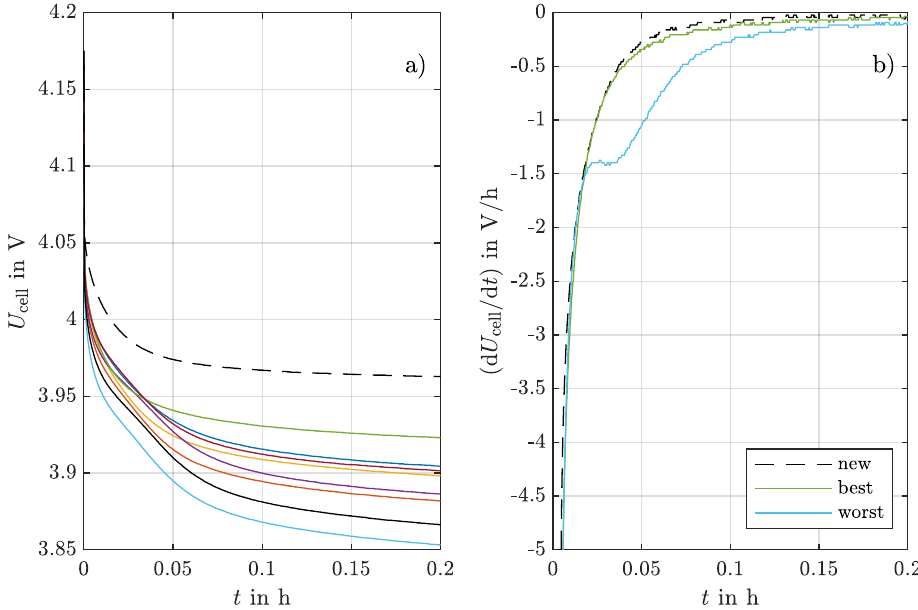
Figure 7. Relaxation measurement of all 8 aged cells and one new cell: ( a ) Voltage during relaxation; ( b ) derivation of the